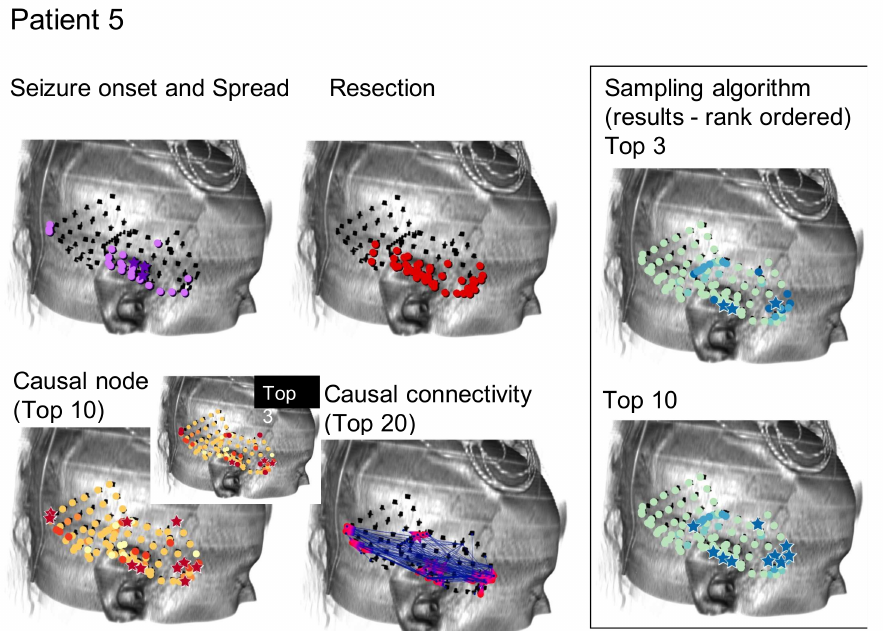
Figure 4. Similar to Figures 2 and 3, results for the Monte Carlo sampling algorithm (1000 random restarts, 1000 samples per random restart) run on one patient are